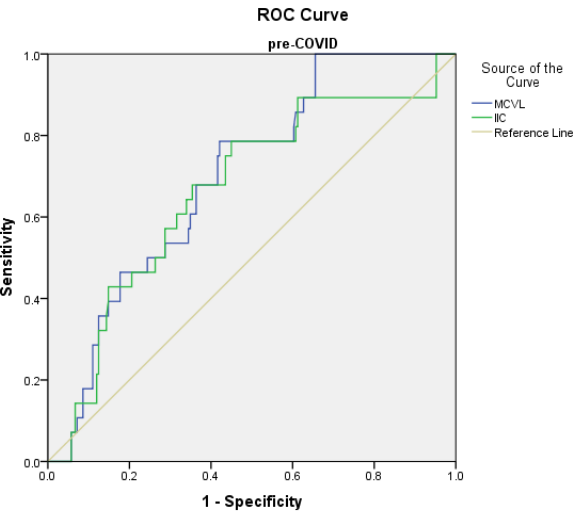
Figure 2. Receiver operating characteristic (ROC) curve for logistic regression models of inflammatory markers in relation to complications in the pre-COVID group.